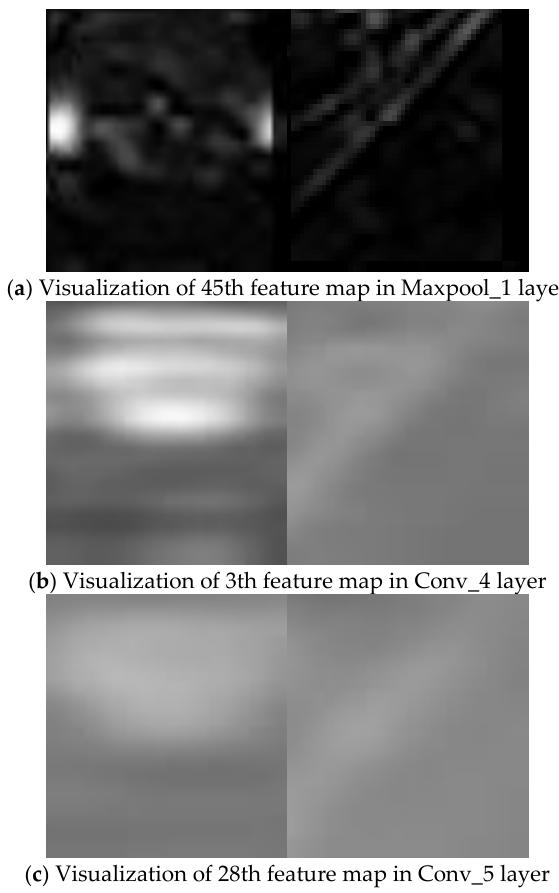
Figure 13. Positive ( left ) and negative ( right ) sample image feature map visualizations.